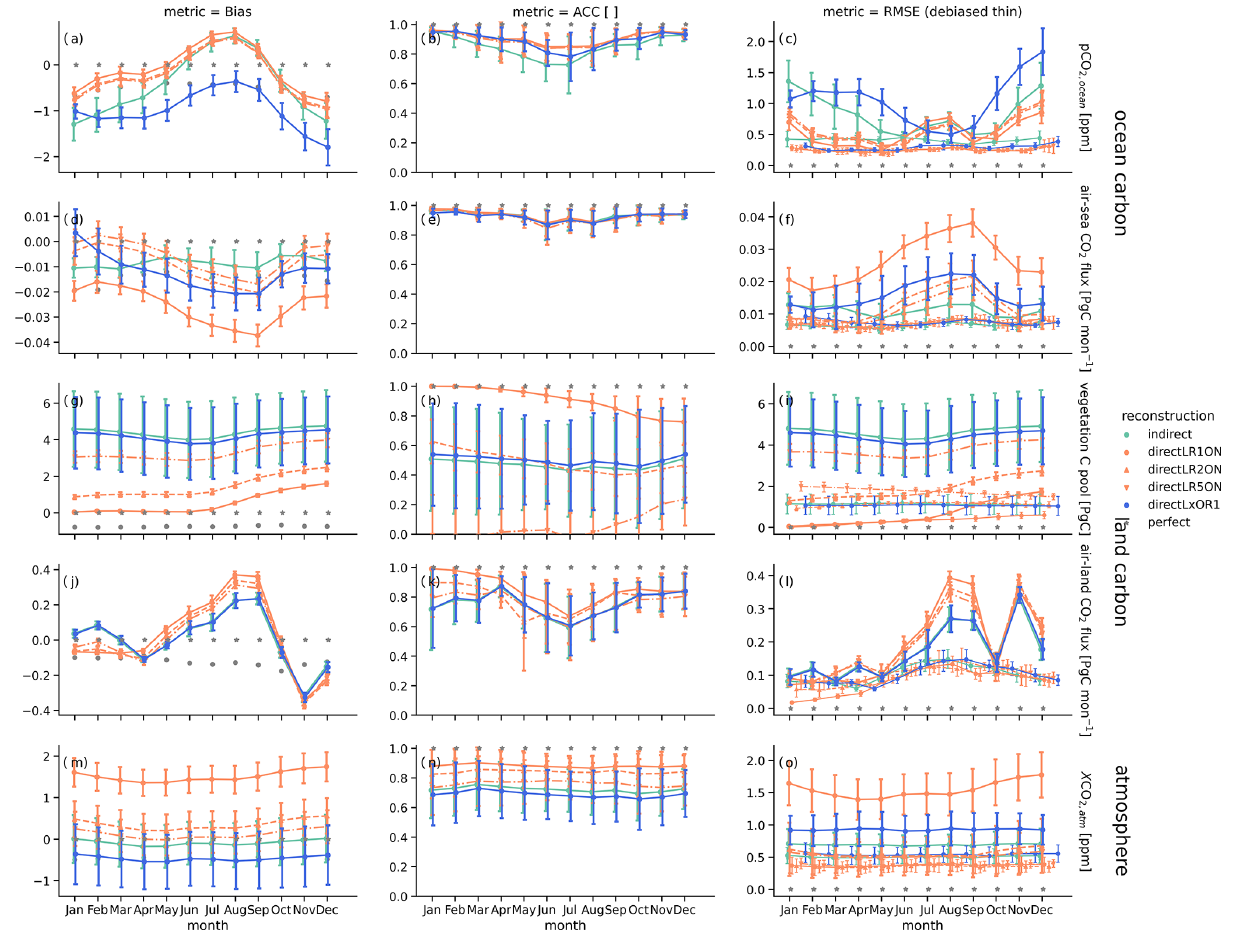
Figure D1. The same as Fig. C1 but for sensitivity simulations of the restart file resetting reconstruction. In all simulations the physical climate is nudged as in indirect simulations (Table 1). DirectLR1ON describes land resetting every year and ocean nudging and is the indirect simulation. DirectLR2ON describes land resetting every second year and ocean nudging. DirectLR5ON describes land resetting every fifth year and ocean nudging. DirectLxOR1 describes no land reconstruction and ocean setting every